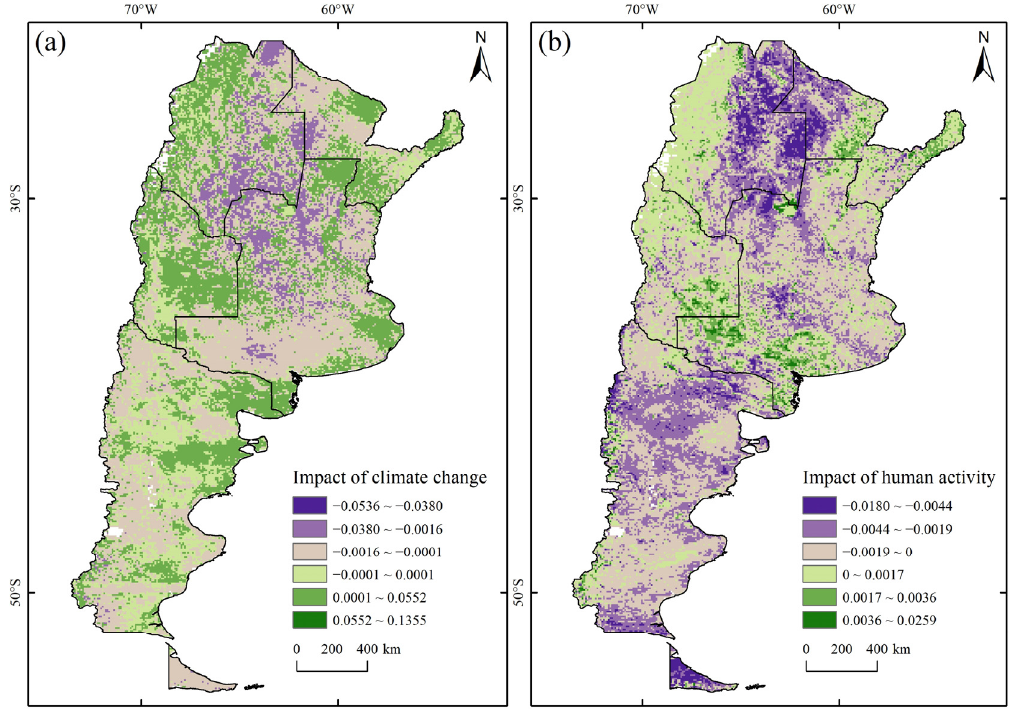
Figure 7. ( a ) The slope of the predicted NDVI (NDVI pre ) in Argentina from 1982 to 2015. ( b ) The slope of the residual NDVI (NDVI res ) in Argentina from 1982 to 2015. Under the influence of human activity, the slope of the NDVI res in Argentina varied from − 0.18 to 0.26/decade, with a slight upward trend (27.49%) in western NWA, eastern NEA, southern Pampas, and Cuyo (Figure 7b). The residual NDVI in eastern NWA, western NEA, Patagonia, and northern Pampas showed a downward trend, accounting for